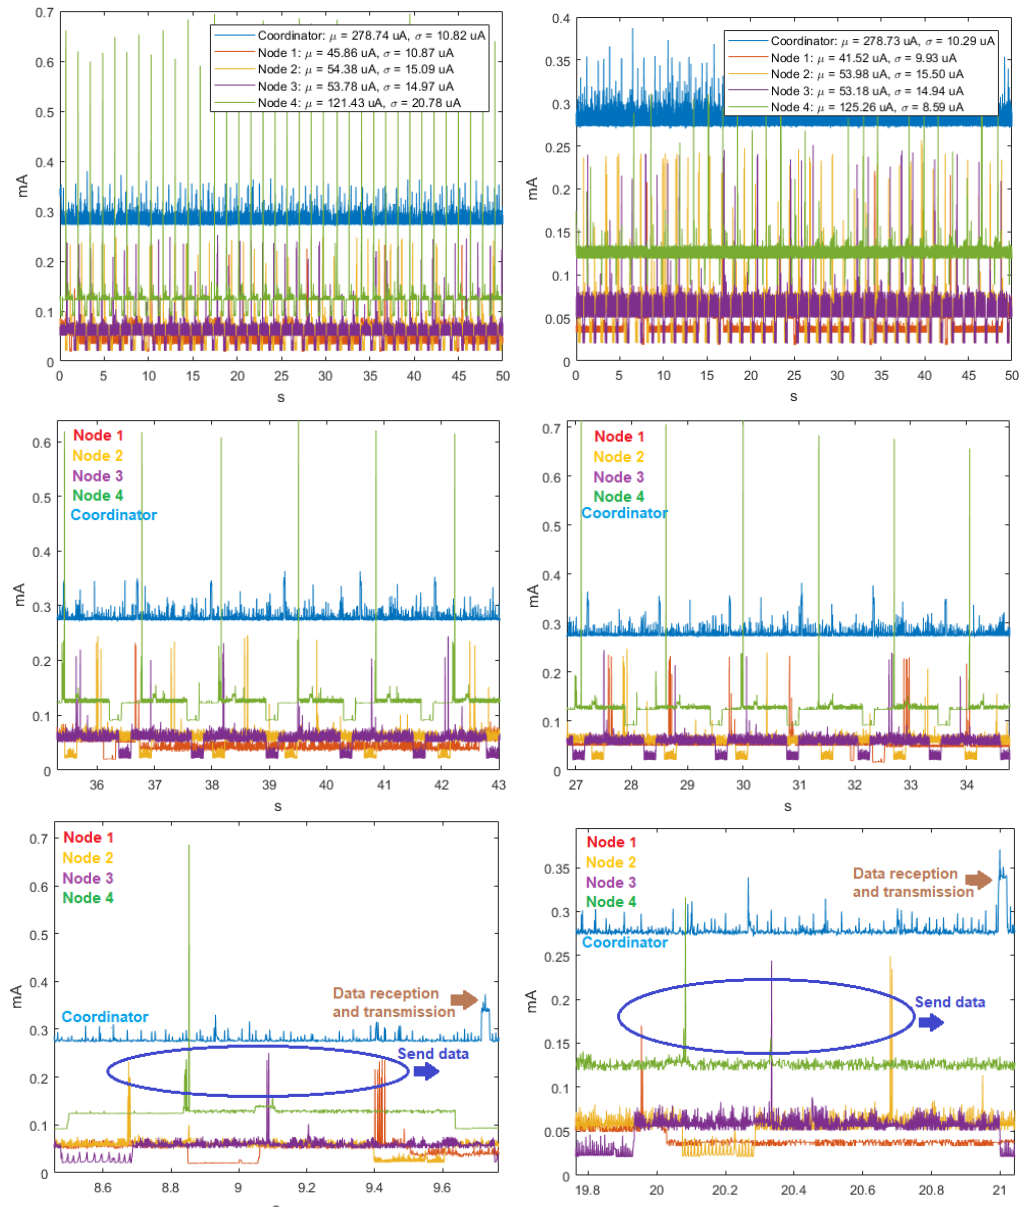
Figure 16. Time signals for WiFi network: ( Left ) at 9600 bauds; and ( Right ) at 57,600 bauds. From top to bottom: total time signal, time detail of the signal, and signal sections with closer